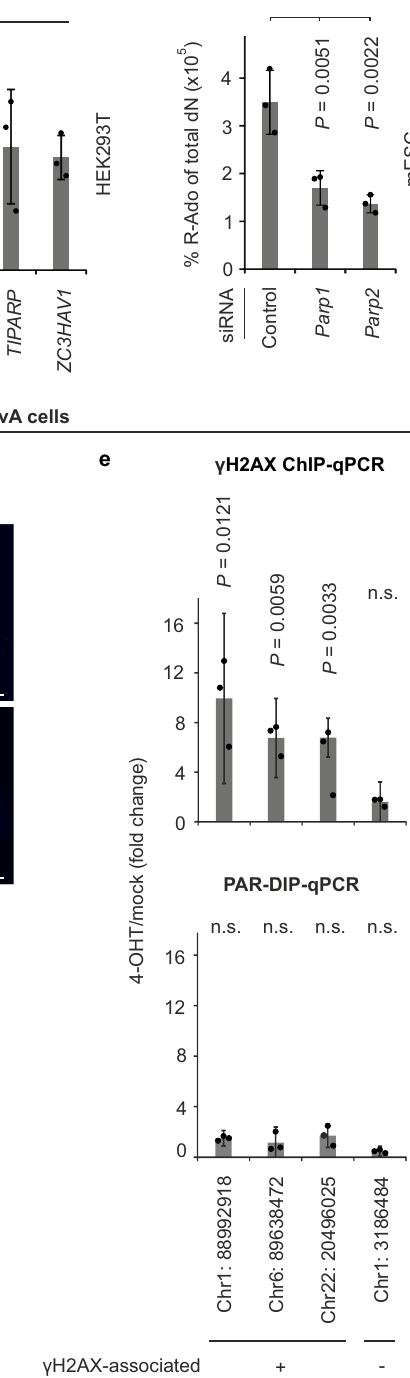
qPCR analysis of selected genomic loci (shown at the bottom) of DIvA cells pre- viously described to be associated with (+) or without ( − ) γ H2AX upon 4-OHT treatment to induce AsiSI nuclease 24 . Bottom: PAR-DIP-qPCR analysis of the same loci as used for top panel. Target regions are named by chromosomal location of the AsiSI recognition site in the human hg38 reference assembly. Data are pre- sented as mean values±s.d. of three biological replicates; indicated p values and not signi fi cant (n.s.) over mock as by two-sided, unpaired t test for unequal var- iances. Source data are provided as a Source Data fi